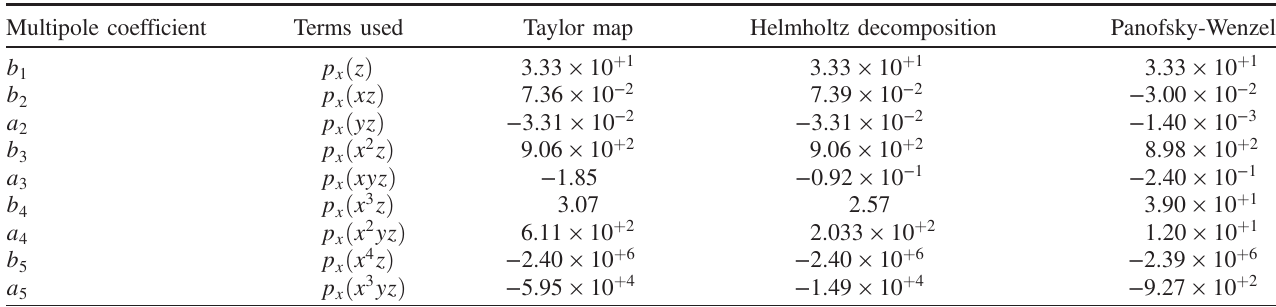
TABLE I. Comparison of multipole coefficients calculated from the Taylor map, compared with the Helmholtz decomposition and Panofsky-Wenzel methods at ρ ¼ 20 mm [22]. Coefficients in units of mT = m n − 1 normalized to 10 MV. Multipole coefficient Terms used Taylor map Helmholtz